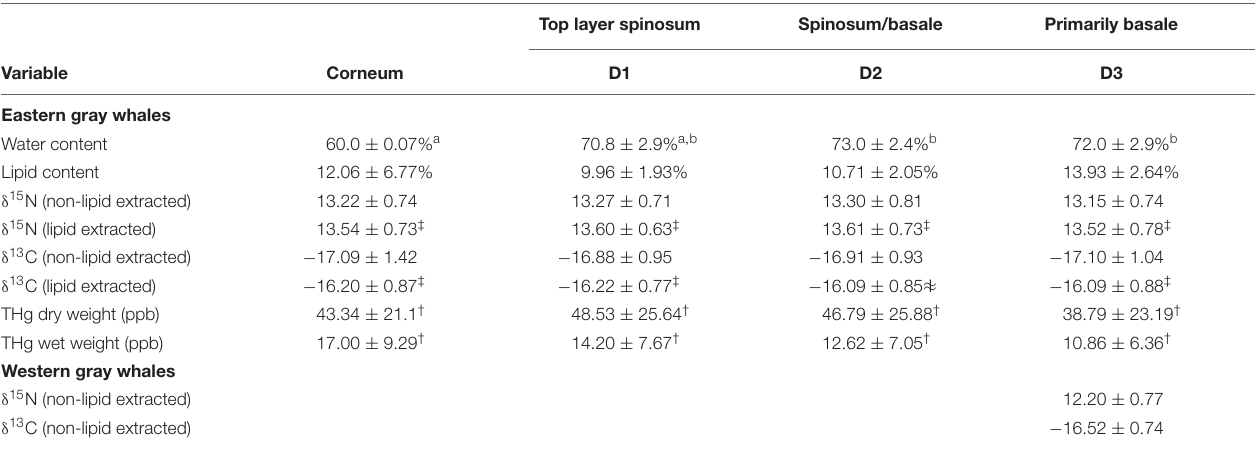
TABLE 1 | Water and lipid content and values of carbon and nitrogen stable isotopes ( δ 13 C and δ 15 N) from different epidermal strata; corneum, spinosum (Depth (D) 1 and 2) and basale (D3) 1 of eastern and western gray whales. Top layer